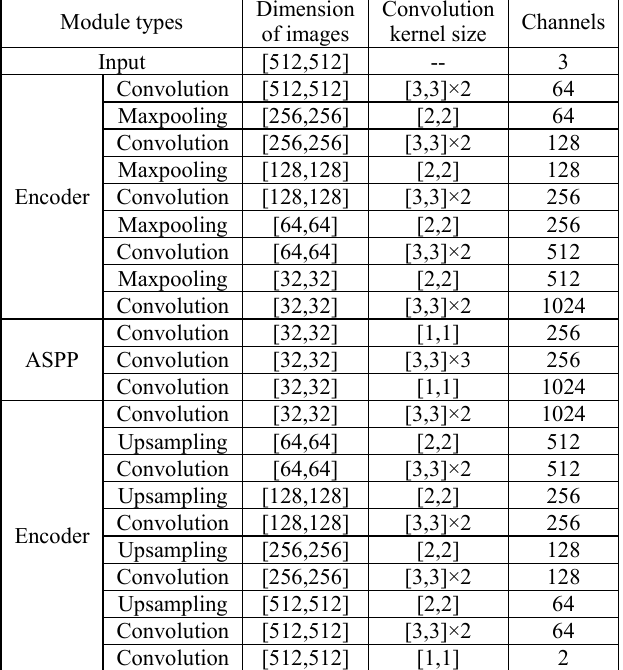
Table 1 Settings of each layer of the network 2.2 Parameter setting for the U-net